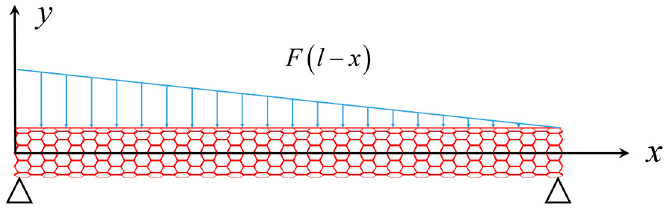
Figure 1. Load on a